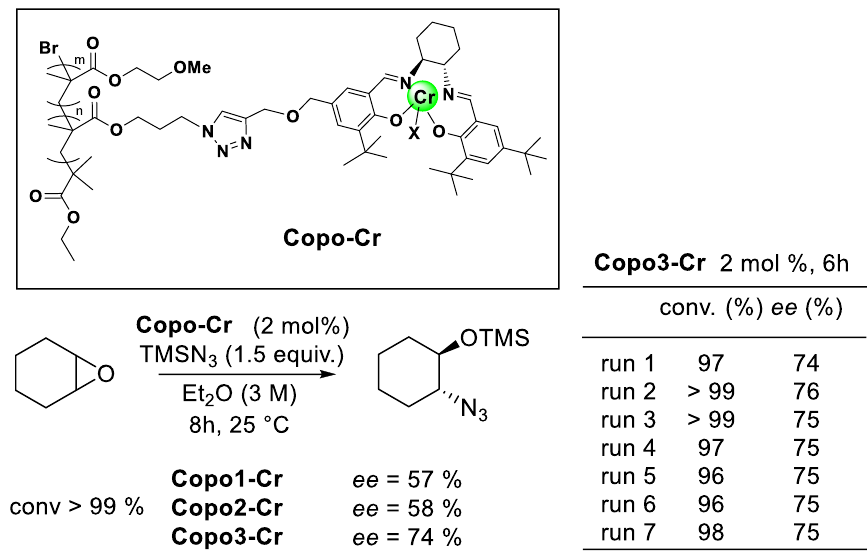
10 of 16 Figure 7. ATR-IR spectra of Copo1 (in blue) and Copo1-Cr (in red). 2.6. Asymmetric Heterogeneous Catalysis This catalytic reaction was performed in the presence of the supported catalysts con- taining 2 mol% of active sites relative to the engaged substrate, in diethyl ether, a solvent in which the polymeric complexes are almost insoluble. When performed in our hands with the classical Jacobsen chromium catalyst, the ring-opened product was obtained with 88% ee , but full conversion was not achieved after 24 h of reaction. This was further con- firmed during the preparation of a racemic sample of